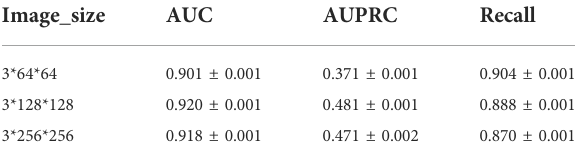
TABLE 5 Experimental results of CAT-CPI on different size images.